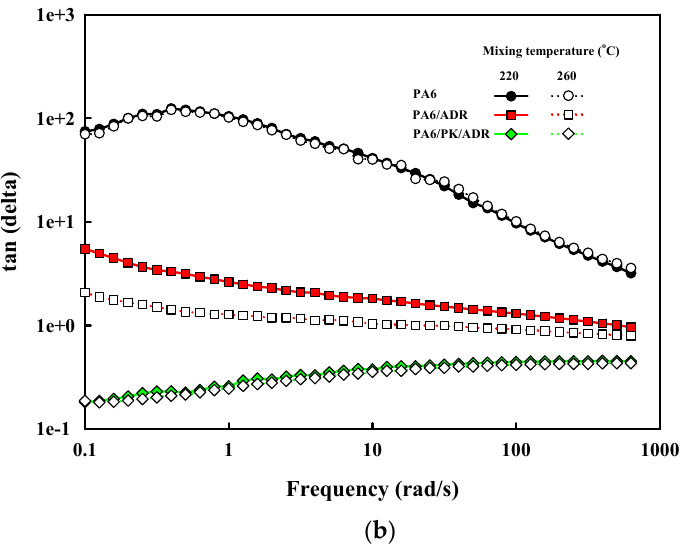
Figure 9. Effect of mixing temperature on the rheological properties of PA6 and PA6/PK blend with chain extender, ADR: ( a ) complex viscosity; ( b ) loss tangent.